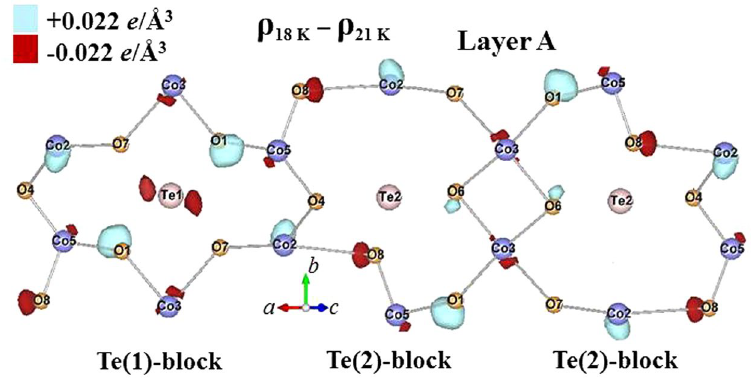
Figure 13. Contour map of the electronic charge density in Layer A that develops upon cooling from 21 K to 18 K, as obtained from the x-ray diffraction data. The regions marked by contours for a difference ECD of + 0.022 e /Å 3 are marked by light (turquoise) shading, while those of − 0.022 e /Å 3 are marked in dark (red)